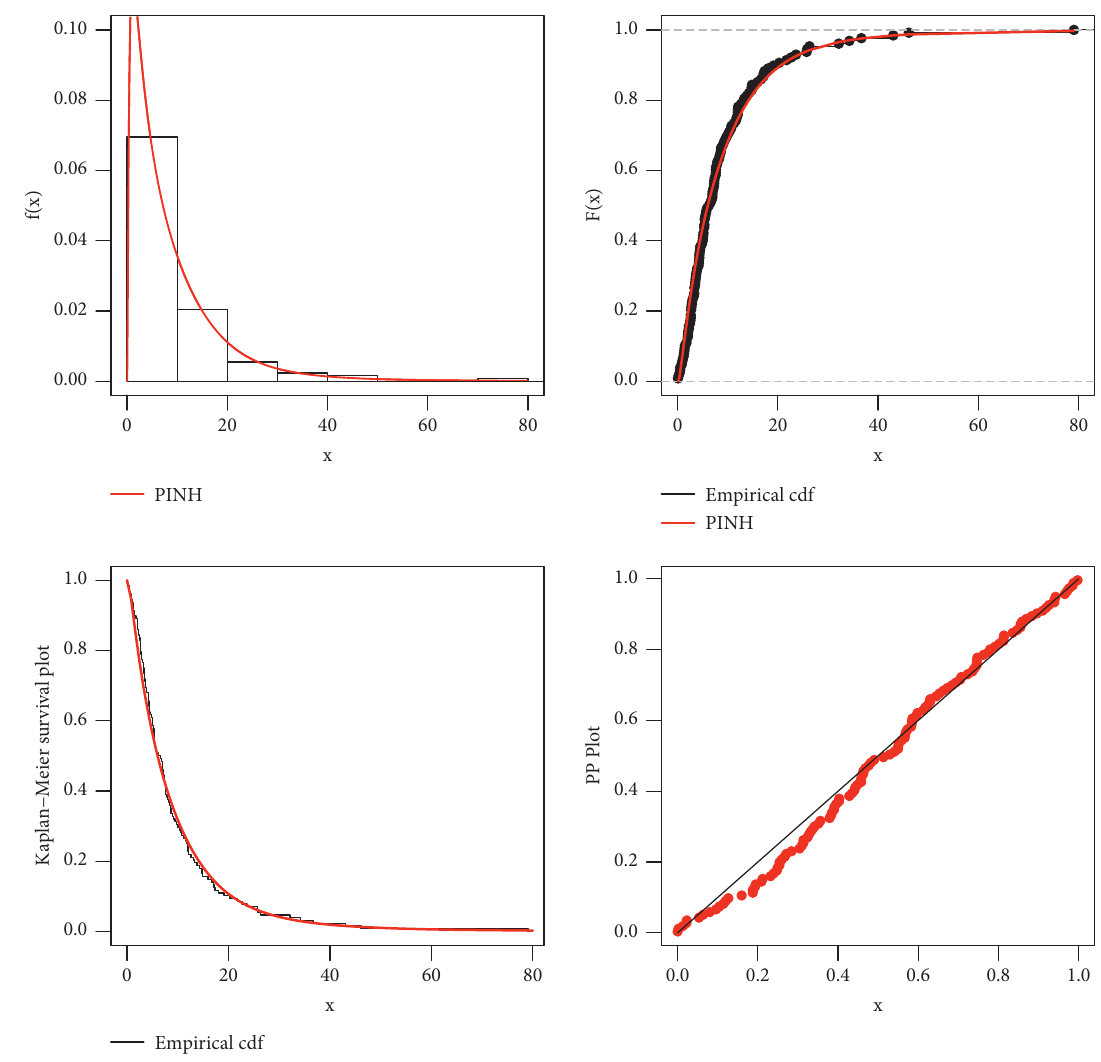
Figure 4: Fitted probability models and empirical data for second data